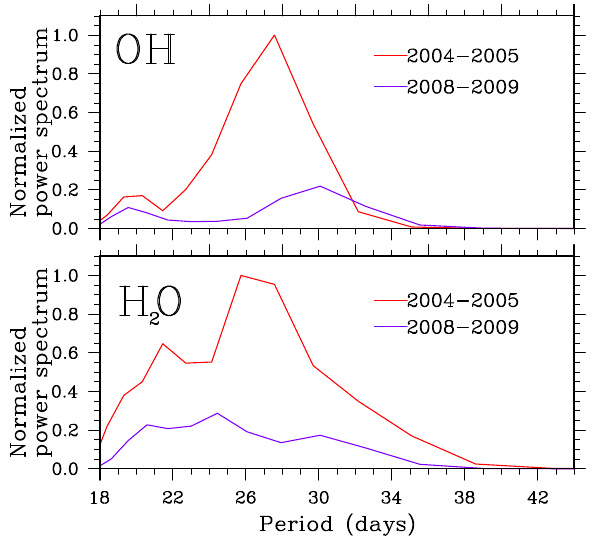
Fig. 5. The normalized power spectra of the tropical mean unfiltered daytime OH (top panel) and H 2 O (bottom panel).